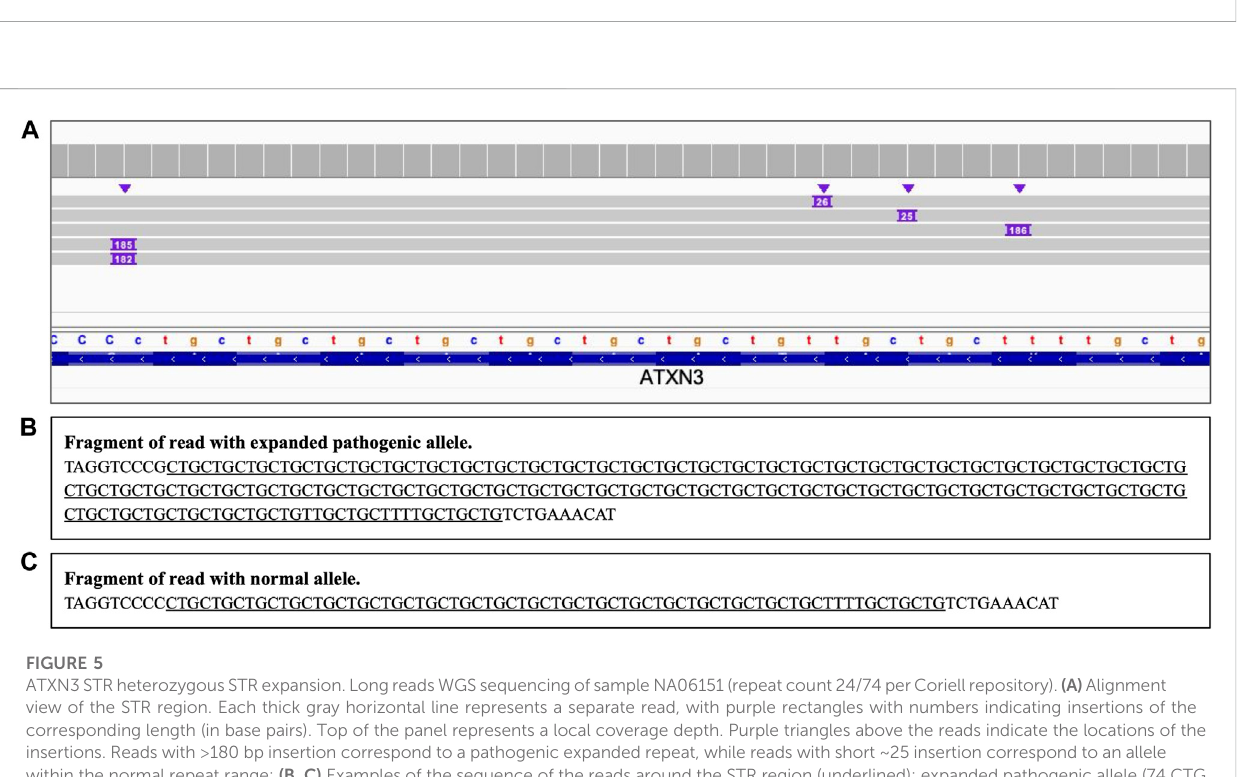
FIGURE 4 DMPK heterozygous STR expansion. Long reads WGS sequencing of sample NA05164 (repeat count 21/340 per Coriell repository information). (A) Alignment view of theSTR region. Each thick gray horizontal line represents aseparateread, with purple rectangles with numbers indicating insertionsof the corresponding length (in bp). Top of the panel represents a local coverage depth. Purple triangles above the reads indicate the locations of the insertions. Reads with long insertion correspond to a pathogenic expanded repeat; (B, C) Examples of the sequence of the reads around the STR region (underlined): expanded pathogenic allele (313 CAG +21 interrupting repeats, panel (B) and normal allele (panel C).